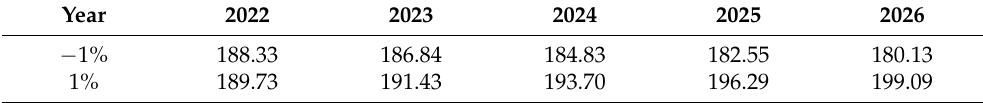
Table 27. Prediction result of water requirement with different growth rates of YEP in Inner